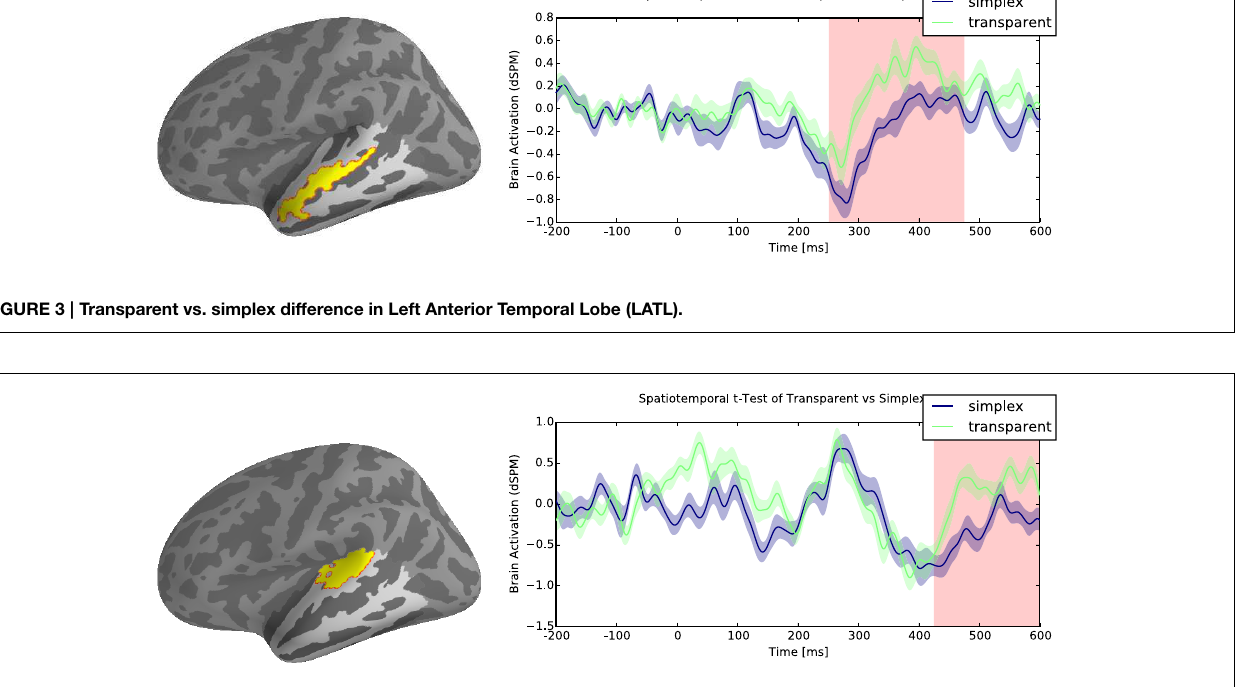
FIGURE 4 | Transparent vs. simplex difference in Posterior Superior Temporal Gyrus (pSTG).